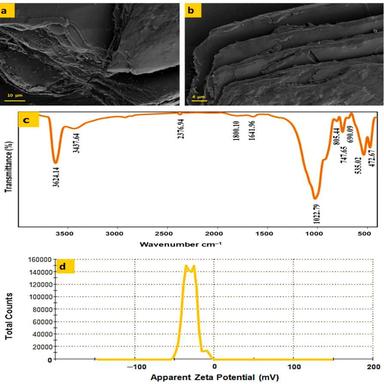
FESEM images (a, and b), FTIR spectrum (c), and zeta potential of Mus sample.